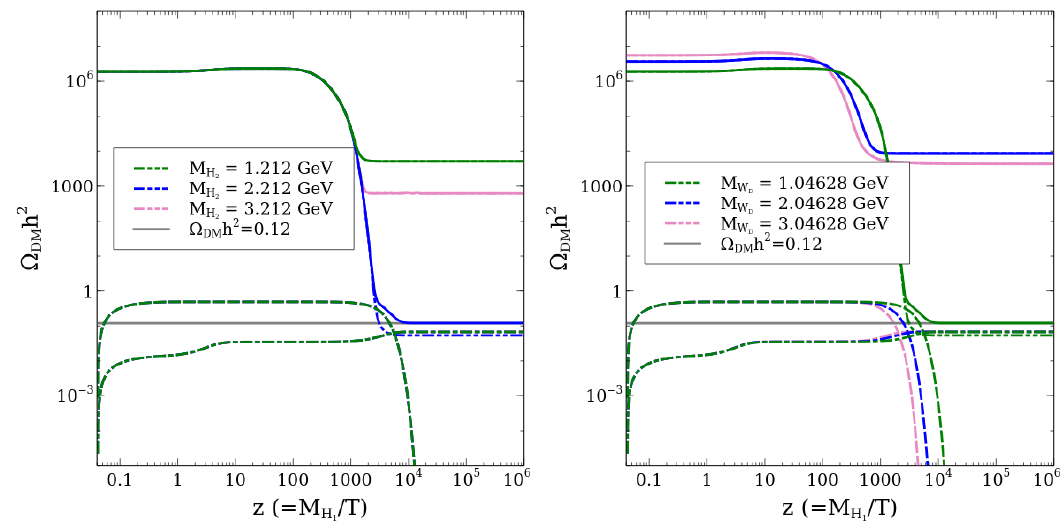
Figure 11 . Dependence of the DM relic densities on three different values of the dark Higgs mass (left) and the dark gauge boson WIMP mass M (right). The other parameters are kept M H W D 2 the same as those given in figure 8. The double-dot-dashed (dot-dashed) lines represent the WIMP (FIMP) DM relic densities, while the dashed lines indicate the NLSP relic densities. The solid lines are the sum of the FIMP and WIMP DM relic densities, while the grey solid line denotes the current DM relic density of